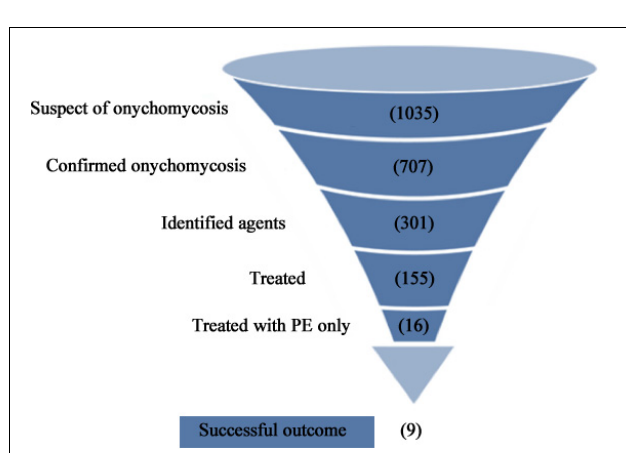
FIGURE 6 | Flow chart of the experimental scheme of the study, from the number (in parentheses) of onychomycosis cases investigated to the successful outcome of treatment with PE. Treated patients, but in other health services where they received other medications and therefore were excluded from this project step. Treated with PE: number of patients who agreed to use PE as the only antifungal drug. Successful outcome: complete recovery of the anatomical appearance of the nail and absence of fungi in the